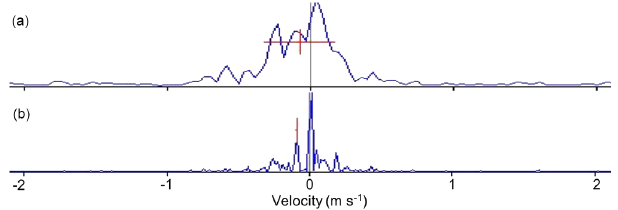
Figure 3. Doppler spectra collected from the 499MHz WPR dur- ing the XPIA field campaign, with typical spectral resolution (a) and higher spectral resolution (b) , accomplished through comput- ing fewer spectral averages on the same dwell. The vertical red lines denote the first moments (mean velocity) and the horizontal red lines denote the spectral widths, using the standard peak pro- cessing